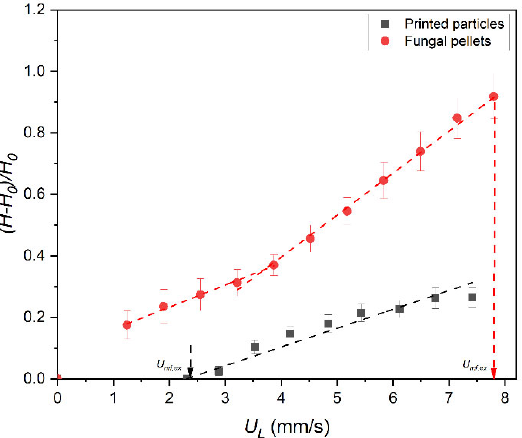
Figure 10. Comparison of the bed height ratio as a function of superficial liquid velocity, U L , for 3D-printedr particles and fungal pellets.